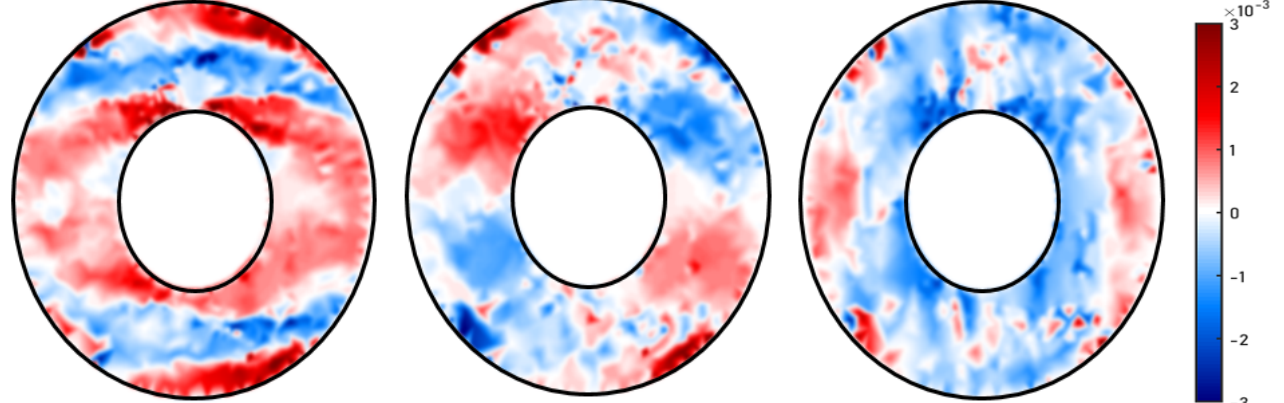
Figure 14. The reconstructed full-field two-dimensional strain components ( ε xx , ε xy , and ε yy ) with FEM